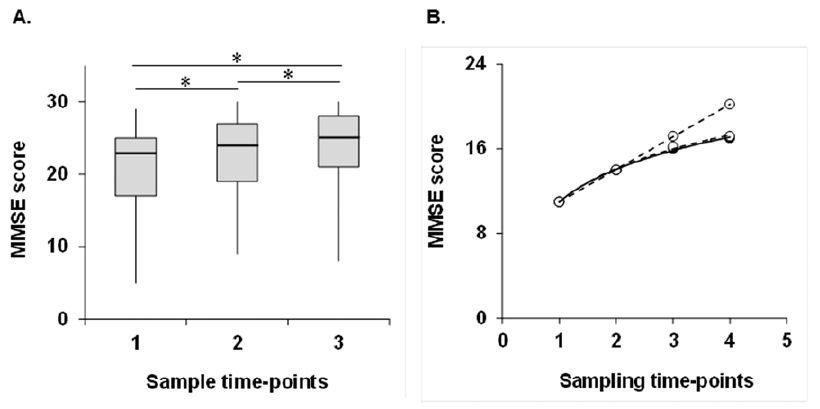
Figure 2. Time course of MMSE score. Plots of actual MMSE scores (filled symbols) from early-phase group data (A) and actual (filled symbols) and predicted MMSE scores (open symbols) from a representative subject (B) are shown. In A, the middle line in the box: median; the ends of the box: interquartile range of the median; the bars: ranges of data distribution; asterisk: P , 0.0001 in the Wilcoxon signed-rank test. The MMSE score increased significantly over the 3 sets of assessment (Friedman’s test, P , 0.0001). In B, the pattern of increase in the predicted values that were derived from the logarithmic model formula was similar to the pattern from the MMSE scores of the representative subject that were actually obtained. However, linear regression modeling overestimated the prediction of cognitive recovery to a greater degree compared with the logarithmic approach. MMSE: Mini-Mental State Examination.